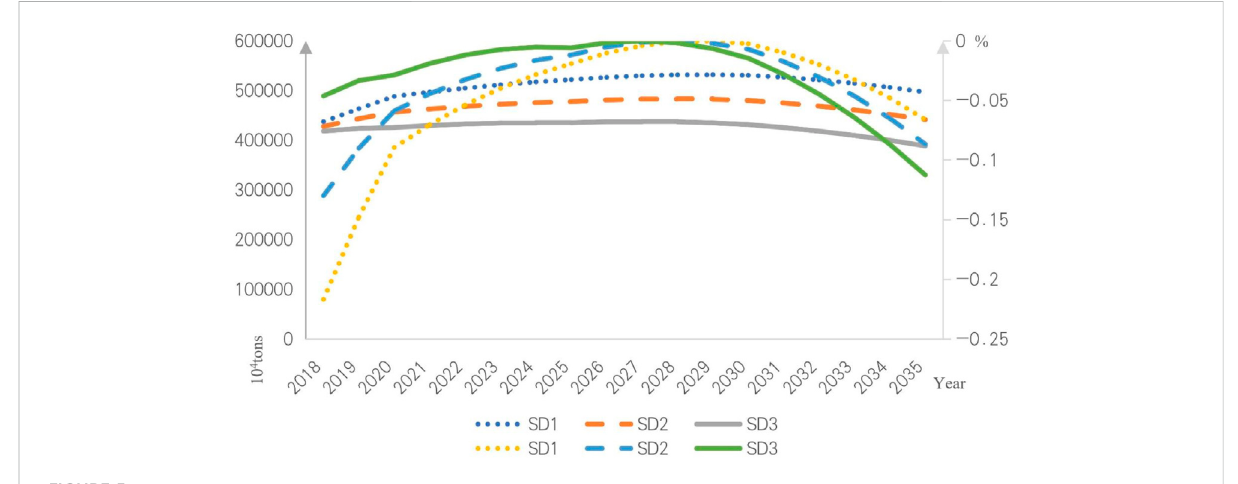
FIGURE 5 Gap between China ’ s coal consumption and peak value under the optimized development scenario from 2018 to